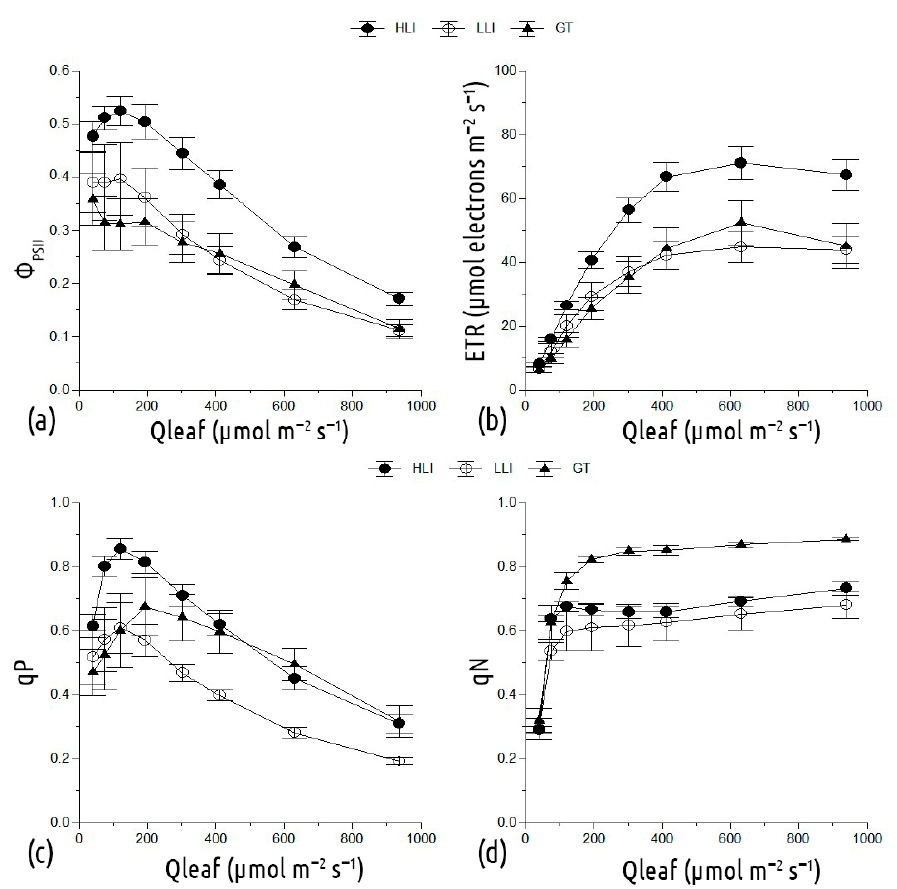
Figure 4. Φ PSII ( a ), ETR ( b ), qP ( c ) and qN ( d ) of an average lettuce plant grown under each different treatment. HLI, High light intensity; LLI, Low light intensity; GT, Glasshouse treatment. Vertical bars indicate ± standard errors of means.